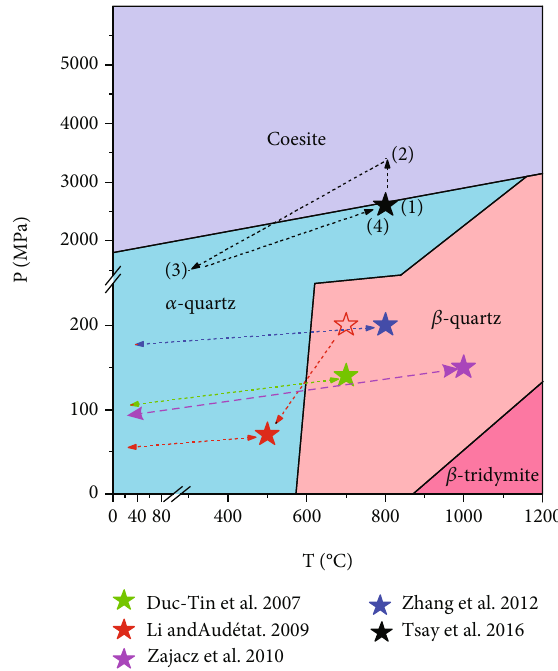
Figure 3: Schematics of the in situ fracturing and the in situ fracturing re fi lled FIS techniques. Notes: stars indicate the temperature and pressure conditions of the experiments; dashed lines and arrows with or without numbers show the rough P-T paths and directions of the experiments. The green star, green dashed line, the magenta star, and the magenta dashed line illustrate the in situ fracturing FIS technique employed by Duc- Tin et al. [53] and Zajacz et al. [69], respectively. The red stars (solid and hollow), red dashed lines, and arrows simply illustrate the in situ fracturing re- fi lled FIS technique reported by Li and Audétat [82]. The hollow star represents the condition of a separate experiment, specially chosen to be higher than that of the second experiment. The blue star and blue dashed line show the in situ fracturing re fi lled FIS technique applied by Zhang et al. [70] in the same experiment at the second step as that at the fi rst step. The black star, black dashed lines, and arrows with numbers illustrate the in situ fracturing FIS technique adopted by Tsay et al.